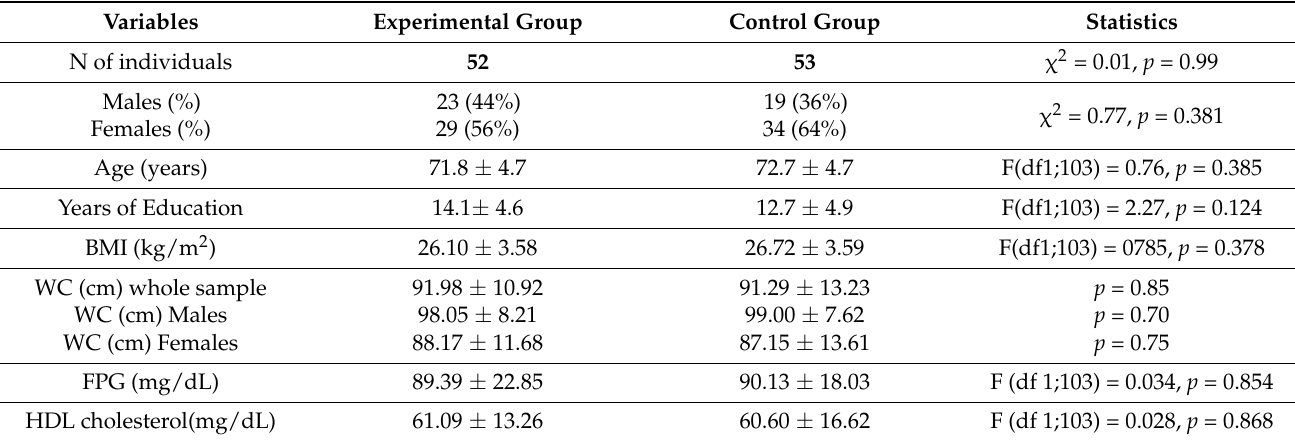
Table 1. Characteristics of the two groups at baseline, before the trial (T0).